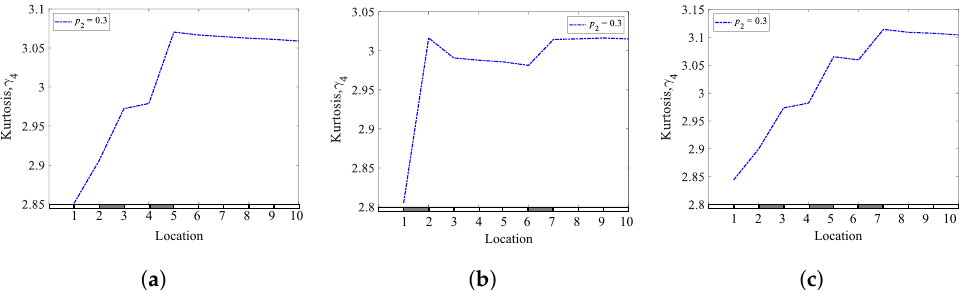
Figure 33. Kurtosis coefficients of a cantilever beam with multiple cracks for different crack depths and locations: ( a ) q = 0.25 and 0.45; ( b ) q = 0.15 and 0.65; ( c ) q = 0.25, 0.45, and 0.65.